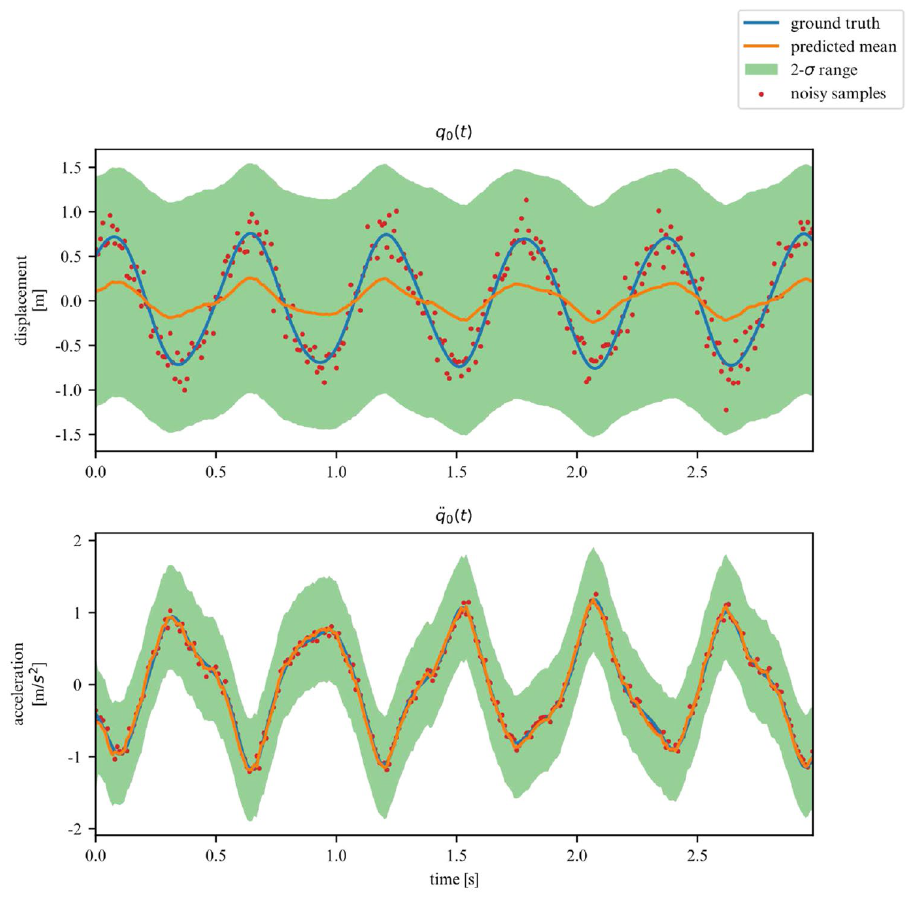
Figure 21. Partially observed duffing 2DOF